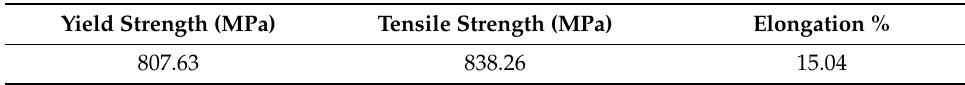
Table 2. Tensile mechanical properties of the base